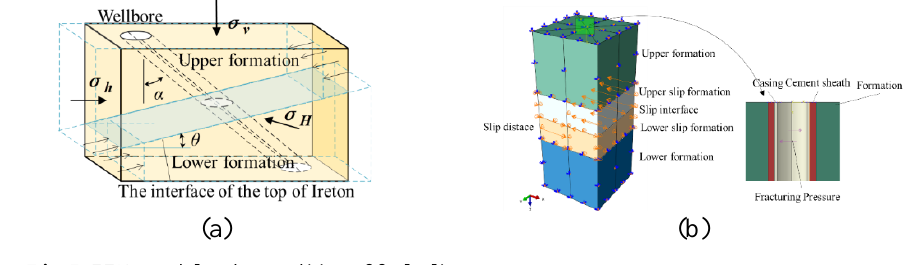
Fig. 5. FEM model at the condition of fault slippage.